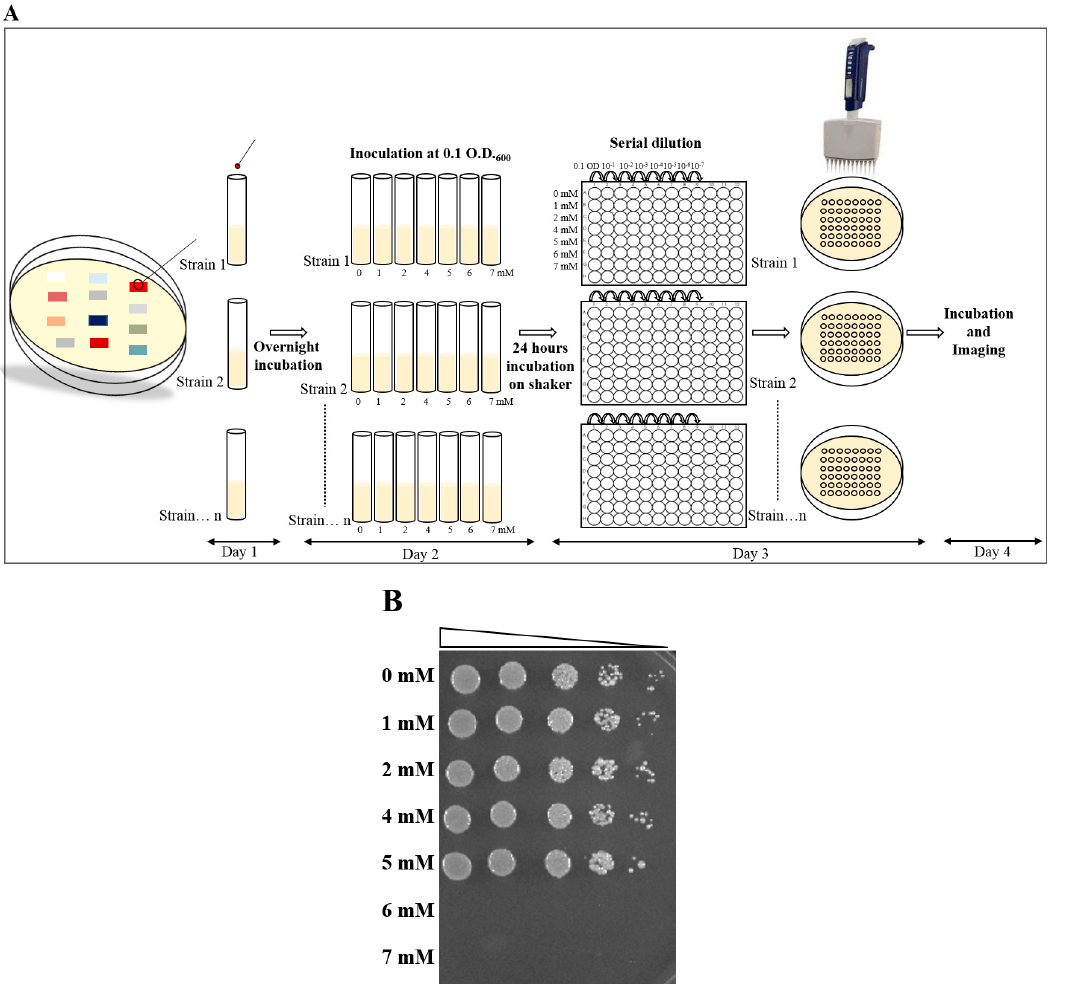
Figure 2. The MIC determination of MA-5-S, using a broth dilution method. ( A ) A schematic shows the steps which were followed in a day-wise manner. ( B ) Represents the plate image taken after 12 h of incubation. The used U concentrations were represented on the left side of the plate.